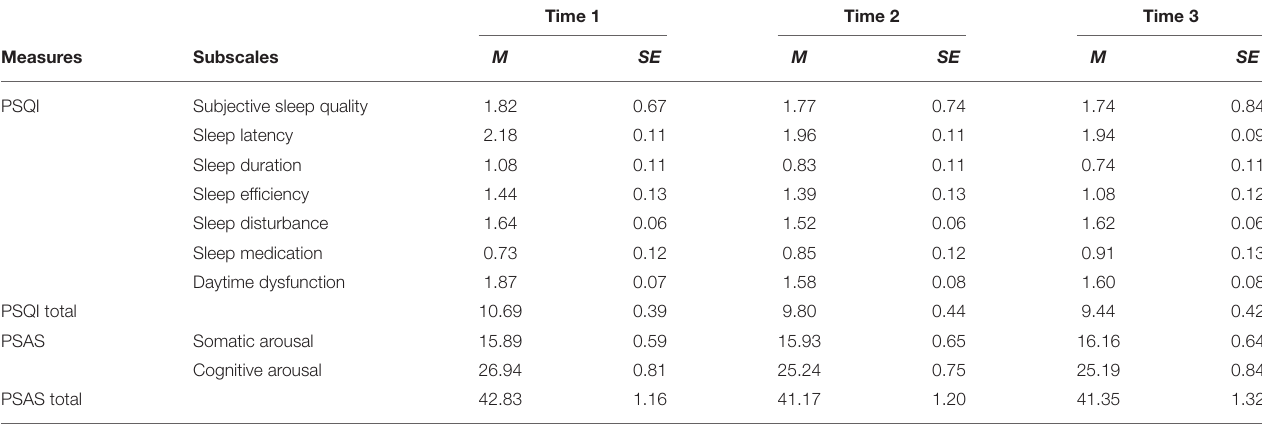
Time 1 Time 2 Time 3